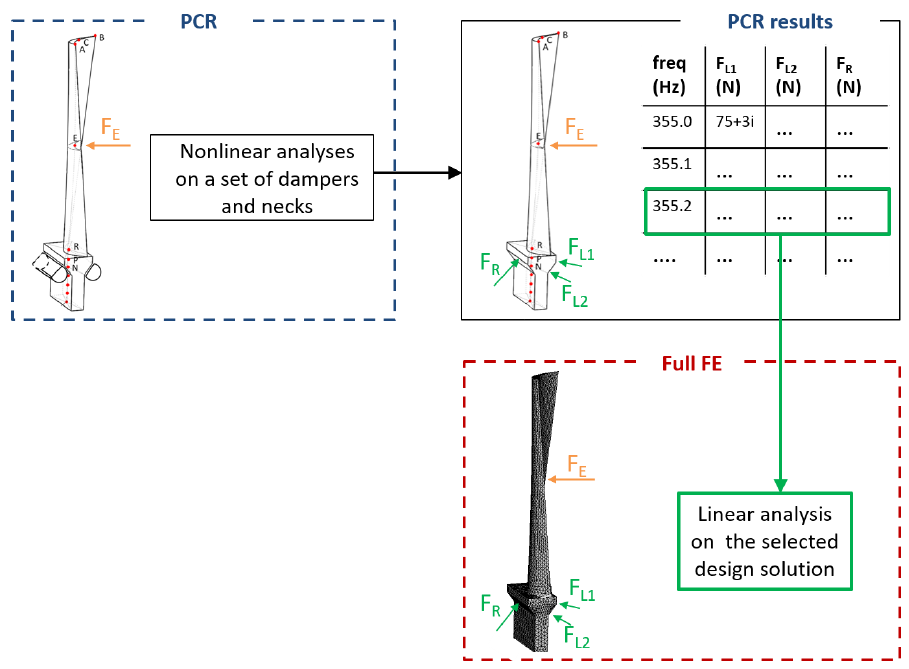
Figure 12. Flowchart representing a typical PCR nonlinear analysis.